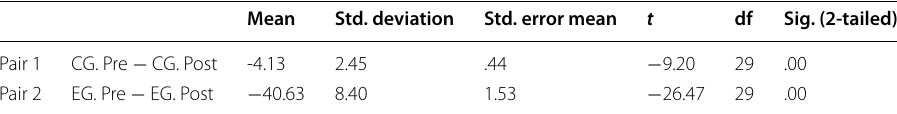
Table 30 Paired samples test (autonomy pre‑ and post‑tests of each group) Mean Std. deviation Std. error